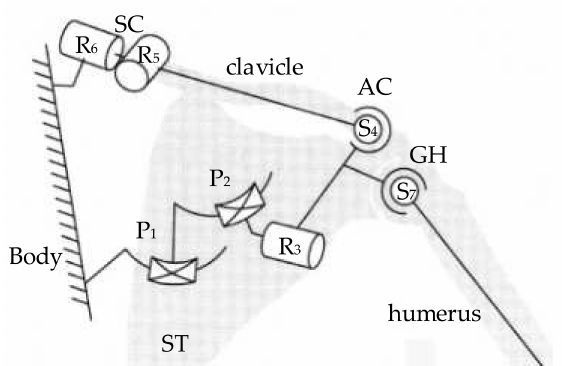
Figure 4. Equivalent mechanism model of the scapula Figure 3. Equivalent mechanism model of the scapula belt.